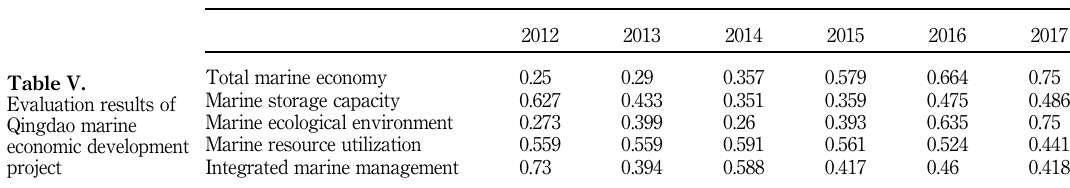
Table IV. Qingdao city economic development quality evaluation index weight